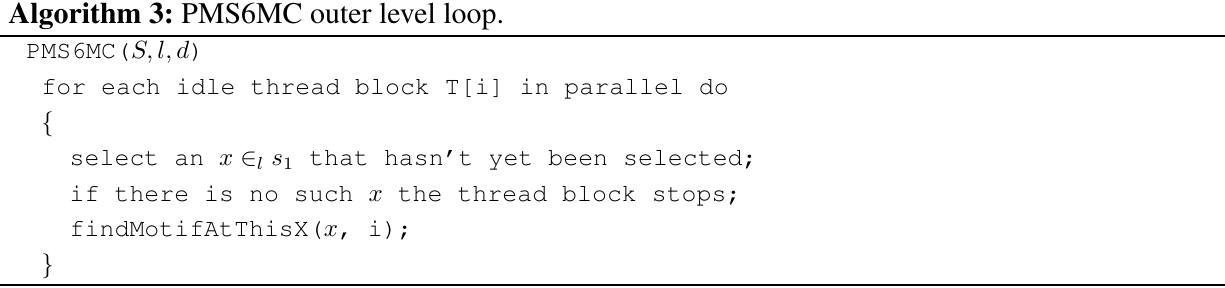
Algorithm 3: PMS6MC outer level